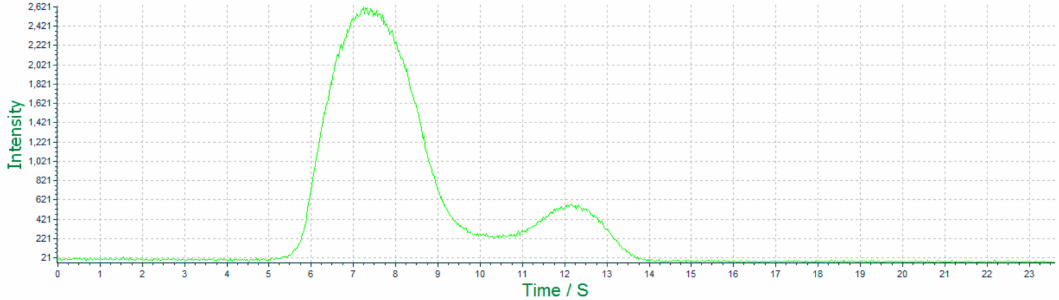
Figure 7. The real-time ECL scanning image of the labeled